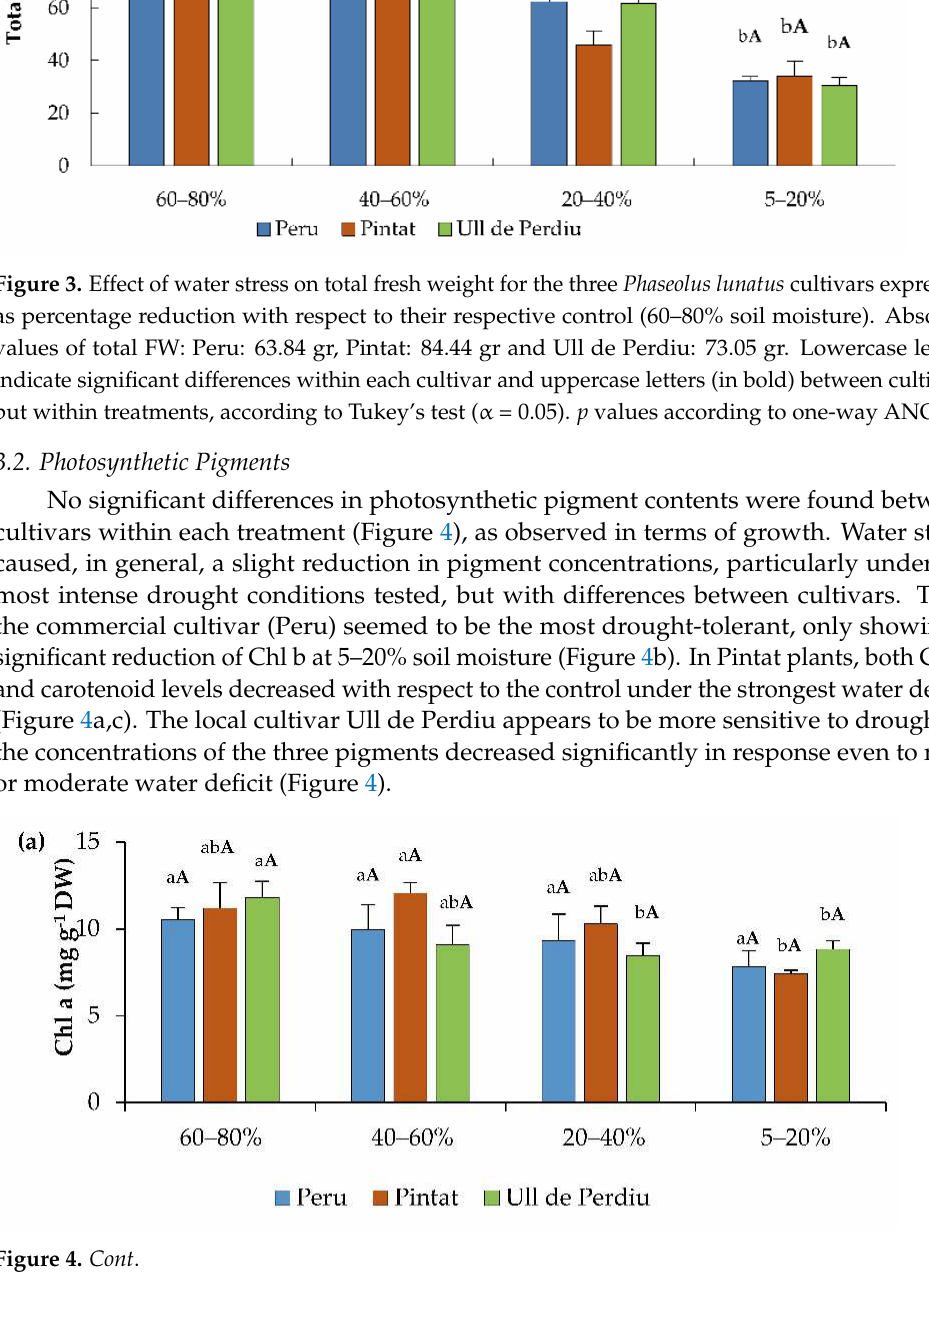
Figure 4. Chlorophyll a (Chl a) ( a ) chlorophyll b (Chl b) ( b ) and carotenoid (Caro) ( c ) contents in leaves of the three Phaseolus lunatus cultivars. Lowercase letters indicate significant differences within each cultivar and uppercase letters (in bold) between cultivars, but within treatments, ac- cording to Tukey’s test (α = 0.05). p values according to one-way ANOVA. 3.3. Ions Accumulation Ion (Na + , Cl − , K + and Ca 2+ ) contents were measured in the roots and leaves of the plants subjected to water stress since they may contribute to cellular osmotic balance and could therefore be involved in the drought response of this species (Table 1). In Peru and Pintat cultivars, Na + and Cl − root contents showed an increasing trend in parallel to in- creasing water deficit—although decreasing again at 5–20% soil moisture in the case of Cl − . Plants of the Ull de Perdiu cultivar showed a different pattern, with decreasing Na + and maintained Cl − contents in response to increasing drought conditions; however, it should be mentioned that the concentrations of both ions in control plants (at 60–80% soil water content) were significantly higher than in the other two cultivars. Regarding Na + and Cl − leaf levels, no significant differences were found, in general, between the different treatments in any of the three genotypes. Moreover, there were no differences between root and leaf contents in plants subjected to the same treatment, with the only exception being Cl − in Peru plants under mild and moderate drought conditions (40–60% and 20–